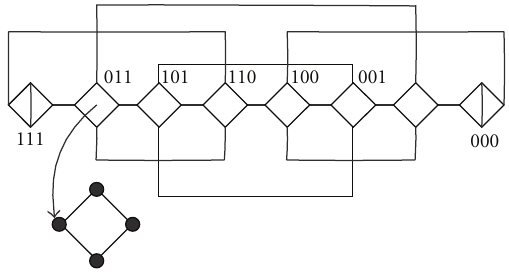
Figure 6: A dBCube(8,2)